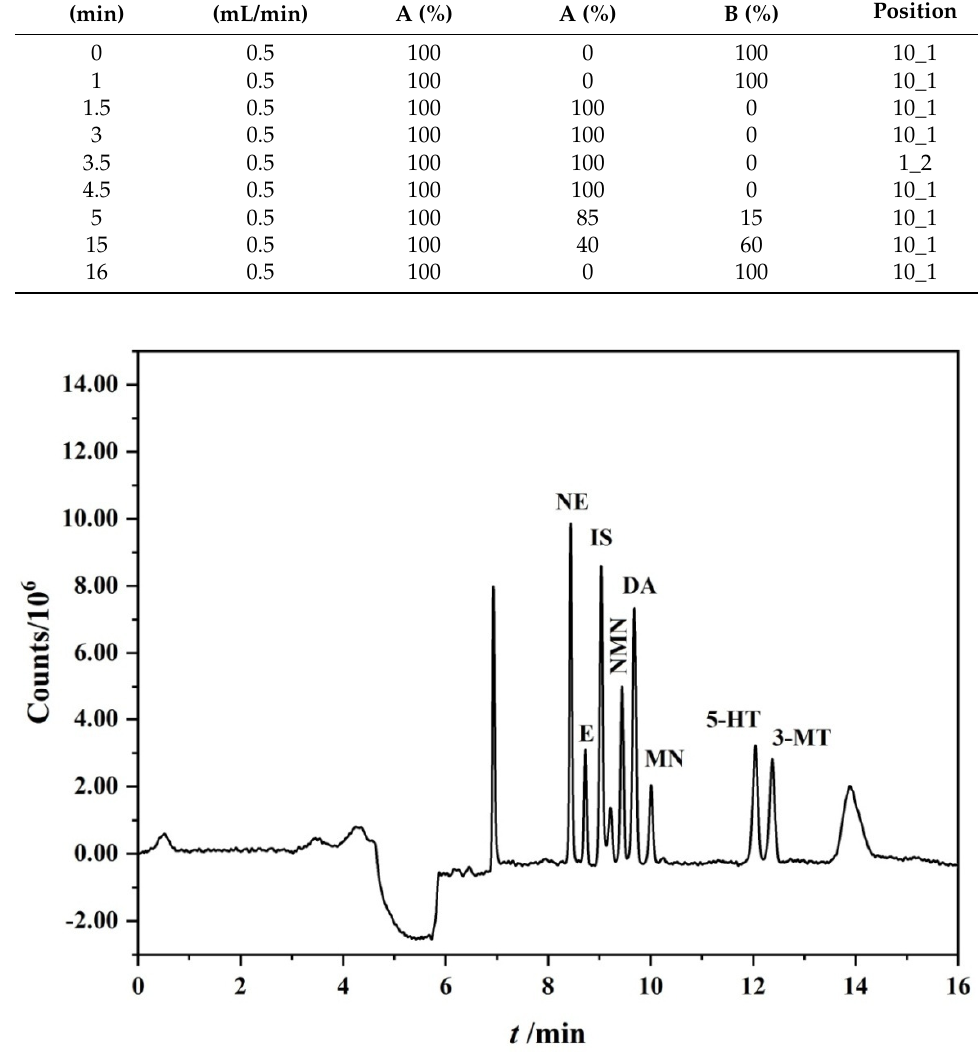
Figure 1. The chromatogram of on-line enrichment and separation of the biogenic monoamines and metabolites.